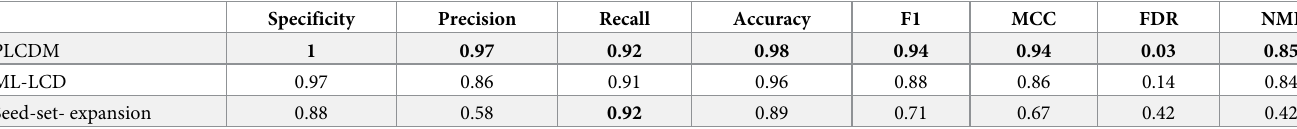
Table 5. Comparison of PLCDM with other methods based on the Multilayer3